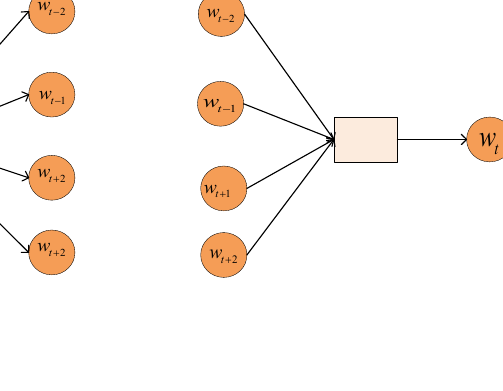
Fig. 2. Skip-gram structure and CBOW structure.